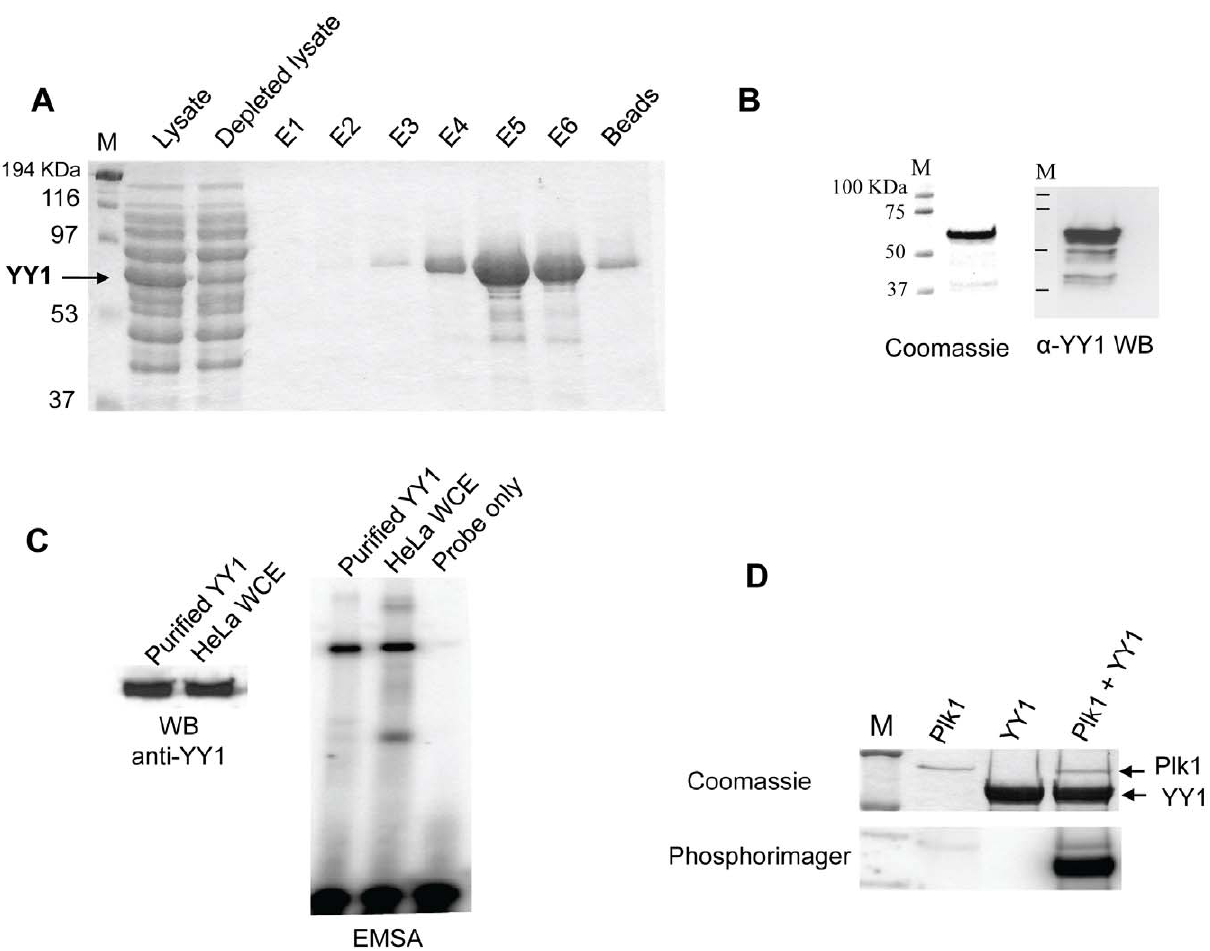
Figure 1. Plk1 phosphorylates YY1 invitro . ( A ) Coomassie blue staining of SDS-PAGE gel showing the purification of bacterially expressed non- tagged YY1 under denaturing conditions. An arrow indicates the position of overexpressed YY1. Lysates: sample from total bacterial lysates; Depleted lysates: sample from bacterial lysates after passing through the Ni-NTA column. E1, 2, and 3 are samples from elutions at pH 5.9; E4, 5, and 6 are samples from elutions at pH 4.5; the last lane shows a sample of the Ni-NTA beads after the last elution step. ( B ) Coomassie blue staining (left panel) and Western blot analysis (right panel) of purified YY1 after renaturation, and separation by SDS-PAGE. In the Western blot, YY1 was probed with anti- YY1 (H-10) antibody. ( C ) EMSA testing the DNA binding activity of purified and renatured YY1 side by side with HeLa whole cell extract. A 22 bp oligonucleotide encompassing the YY1 binding site in histone H3.2 coding region was used as the radioactively labeled probe. The Western blot shows equal amounts of purified YY1 and YY1 protein in HeLa WCEs. ( D ) Coomassie blue staining and phosphorimager exposure of SDS-PAGE gel after radioactive in vitro kinase assay, using purified Plk1 and YY1. The gel shows three reactions: Plk1 only, YY1 only, and Plk1 plus YY1; as indicated.